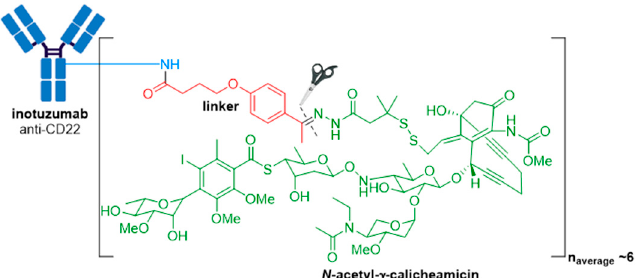
Figure 9. Structure of Besponsa ® (inotuzumab ozogamicin). The antibody is shown in blue, and chemical structures for linker and payload are in red and green, respectively.